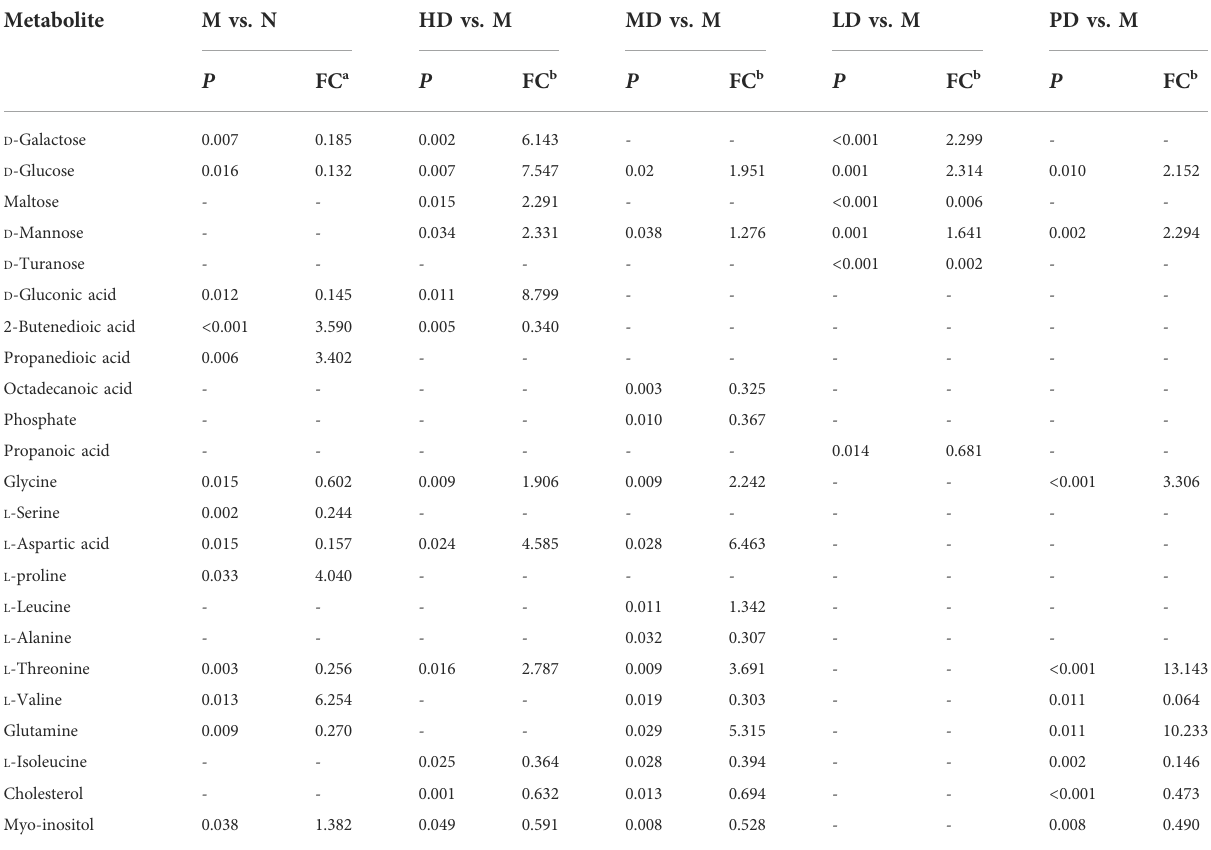
TABLE 2 Intervention of ASH and fl uoxetine on different metabolites in the liver of CUMS mice.